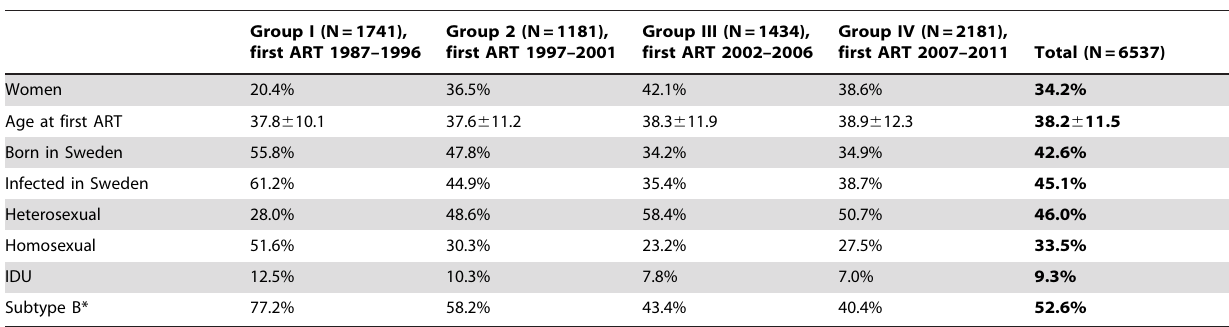
Table 1. Patient characteristics of Groups